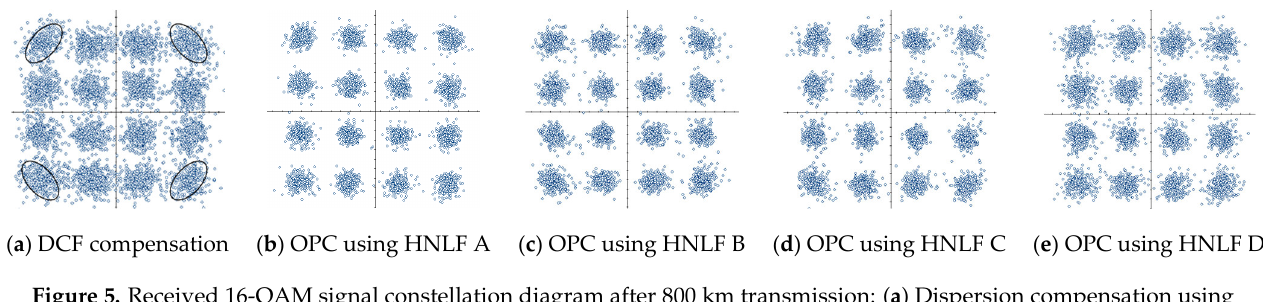
Figure 5. Received 16-QAM signal constellation diagram after 800 km transmission: ( a ) Dispersion compensation using dispersion compensated fiber (DCF); ( b ) mid-link OPC using 550 m HNLF A; ( c ) mid-link OPC using 500 m HNLF B; ( d ) mid-link OPC using 750 m HNLF C; ( e ) mid-link OPC using 800 m HNLF D.